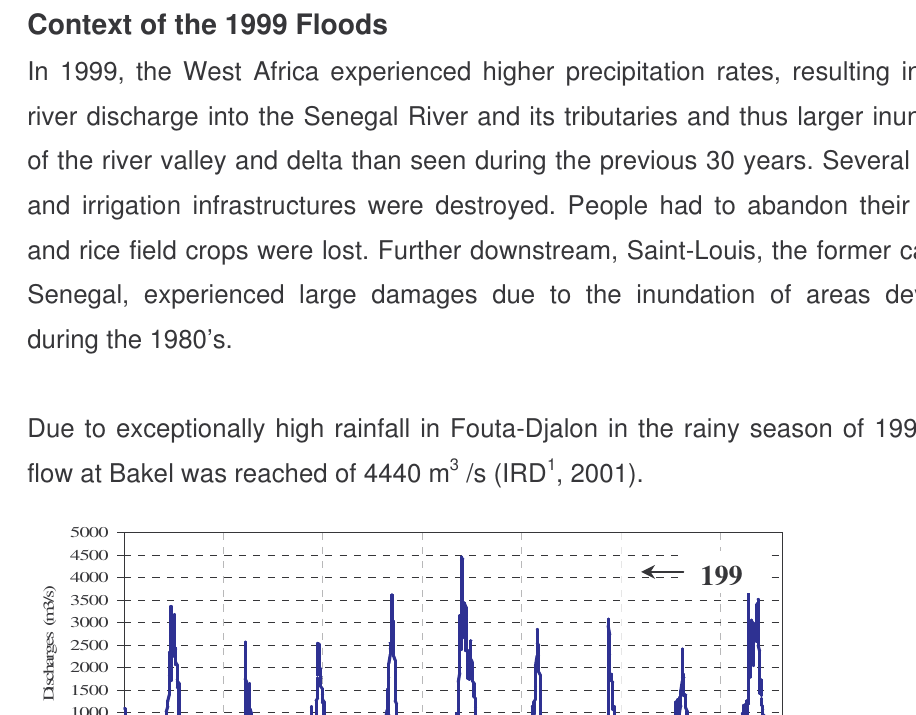
Context of the 1999 Floods